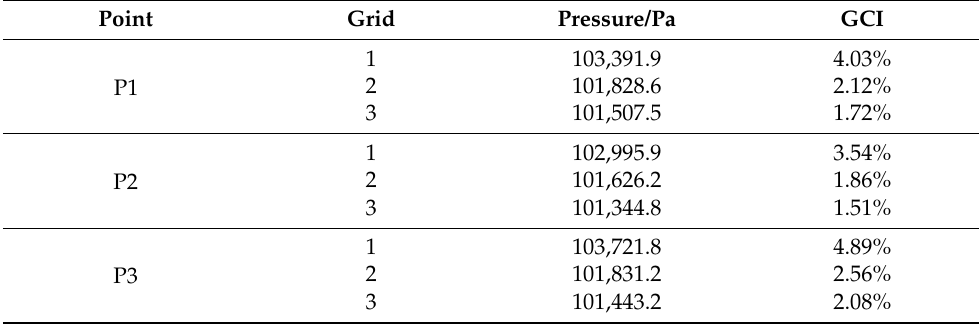
Table 2. Calculated results of GCI.